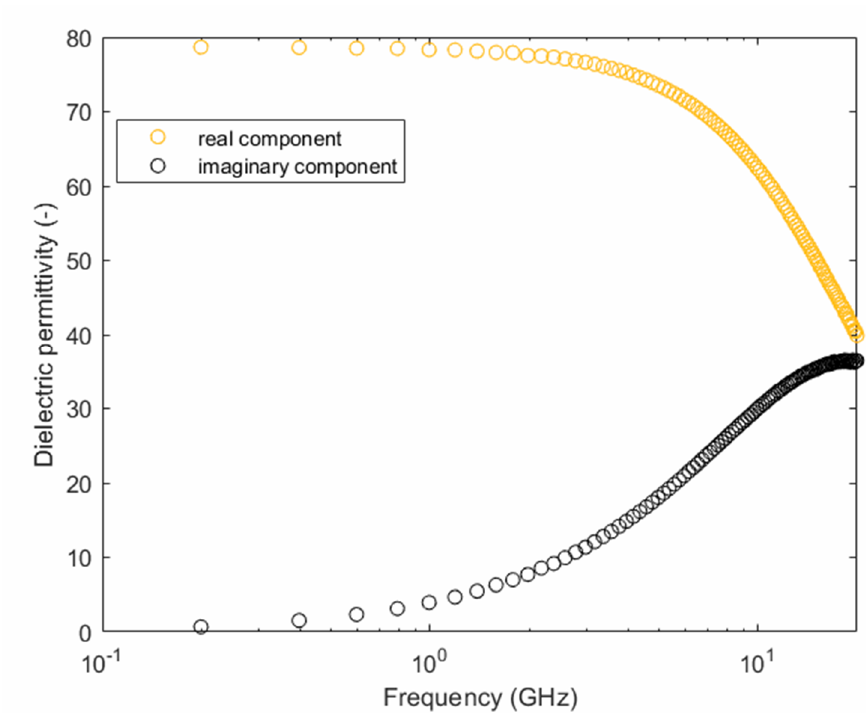
Figure 4. Real and imaginary dielectric permittivity measured on distilled water.